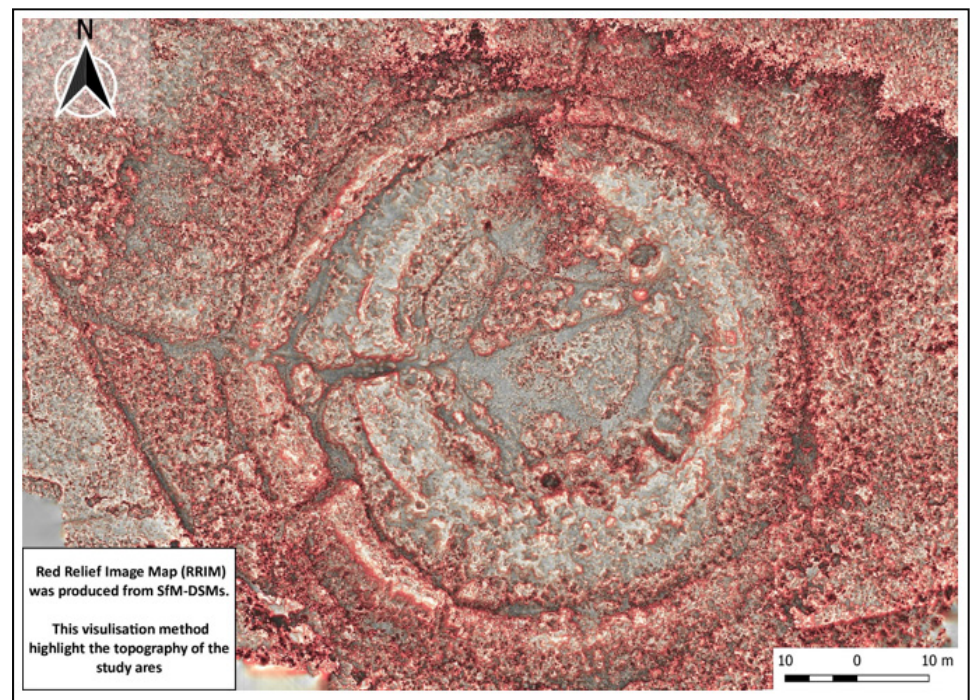
Figure A1. RRIM highlight the archaeological topography of Chun castle by combining multilayers: slope raster, differential openness, and differential openness generated from SfM data.